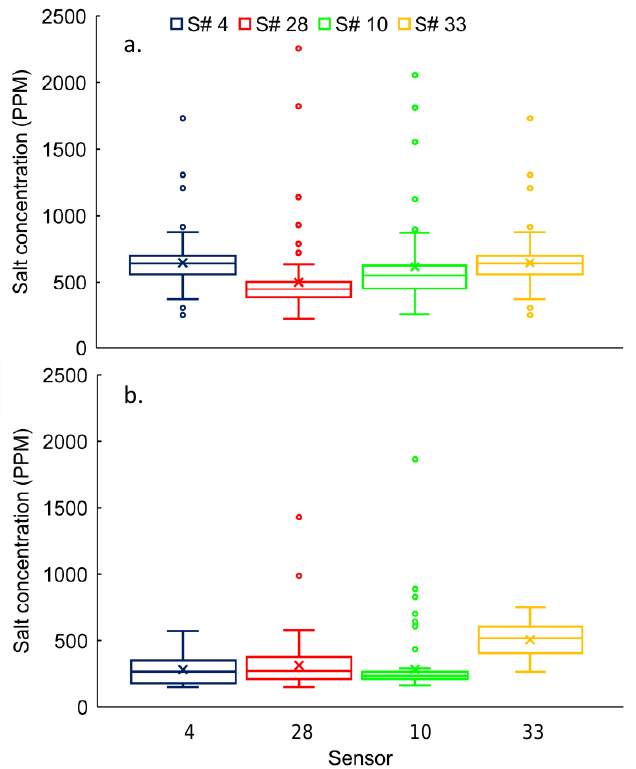
Figure 5. Salt concentrations distribution at urban-stream for S# 4, 28, 10, and 33 during ( a ) winter and ( b ) spring seasons.